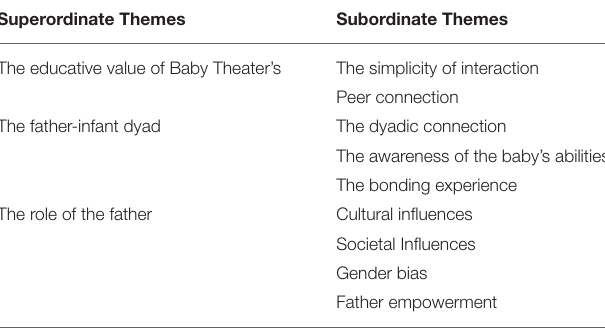
TABLE 2 | Superordinate and subordinate themes. Superordinate